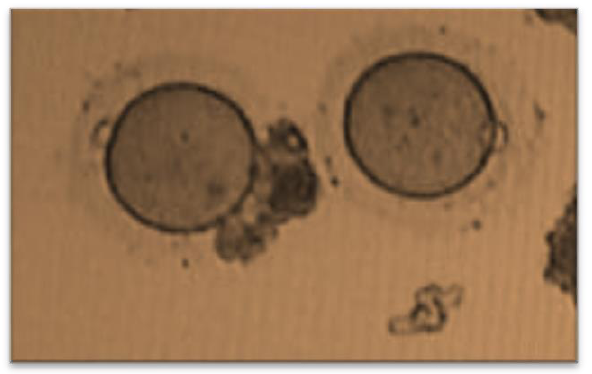
Figure,5: 8 cells Embryo